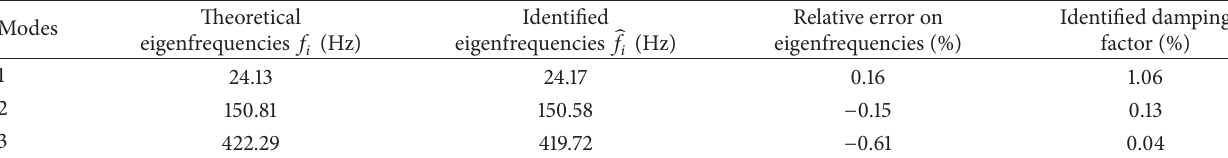
Table 1: Natural eigenfrequencies and damping factors of the experimental beam.